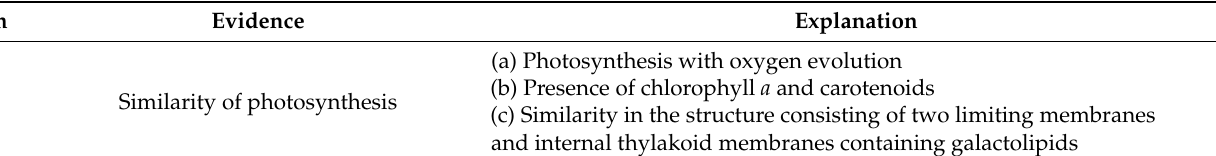
Table 1. Evidence for the cyanobacterial origin of